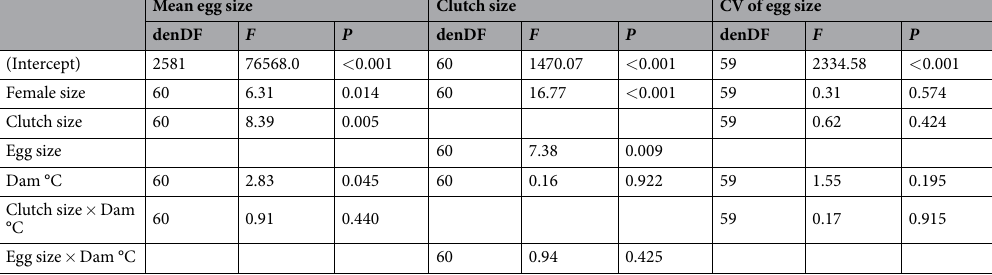
Table 1. Mean egg size, clutch size and the coefficient of variation (CV) of egg size for stickleback ( Gasterosteus aculeatus ) mothers acclimated to the four temperature treatments (Dam °C) analysed using generalised linear mixed effects models (GLMMs). Female (individual) was modelled as a random effect, Dam °C was modelled as a fixed effect, and female size, clutch size or egg size were included as covariates. Numerator degrees of freedom were 1 in all cases except for Dam °C and the interaction terms (numDF = 3). denDF indicates